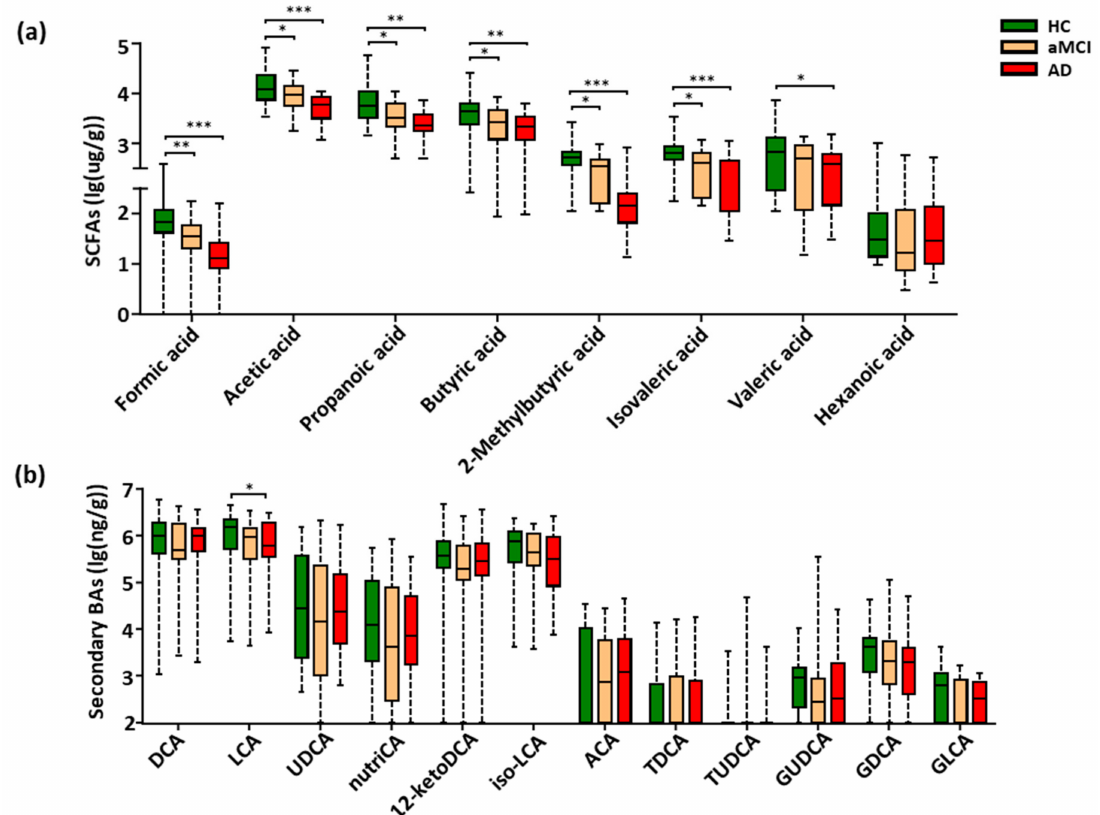
Figure 3. Progressively decreased SCFAs and LCA from HC to aMCI and AD patients. ( a , b ) Comparison of fecal SCFAs and fecal secondary bile acids among the HC, aMCI, and AD groups. Note: Data are given as median with range and P values were calculated using one-way ANOVA or Kruskal–Wallis test. * p < 0.05; ** p < 0.01; *** p < 0.001. Abbreviations: SCFAs, short-chain fatty acids; DCA, deoxycholic acid; LCA, lithocholic acid; UDCA, ursodeoxycholic acid; nutriCA, nutriacholic acid; 12-ketoDCA, 12-ketodeoxycholic acid; iso-LCA, isolithocholic acid; ACA, allocholic acid; TDCA, taurodeoxycholic acid; TUDCA, tauroursodeoxycholic acid; GUDCA, glycoursodeoxycholic acid; GDCA, glycodeoxycholic acid; GLCA, glycolithocholic acid; BAs, bile acids; ANOVA, analysis of